Question: Give a one-sentence summary of this figure.
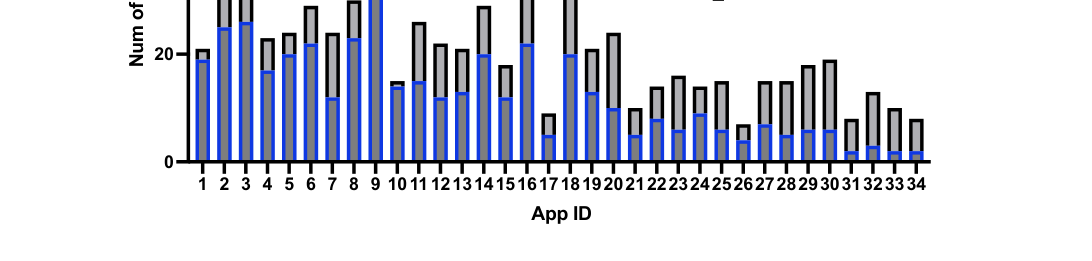
Answer: Activity launch type distribution. DY_launch stands for dynamically launched activities, whereas DP_launch refers to activities launched via deep links.